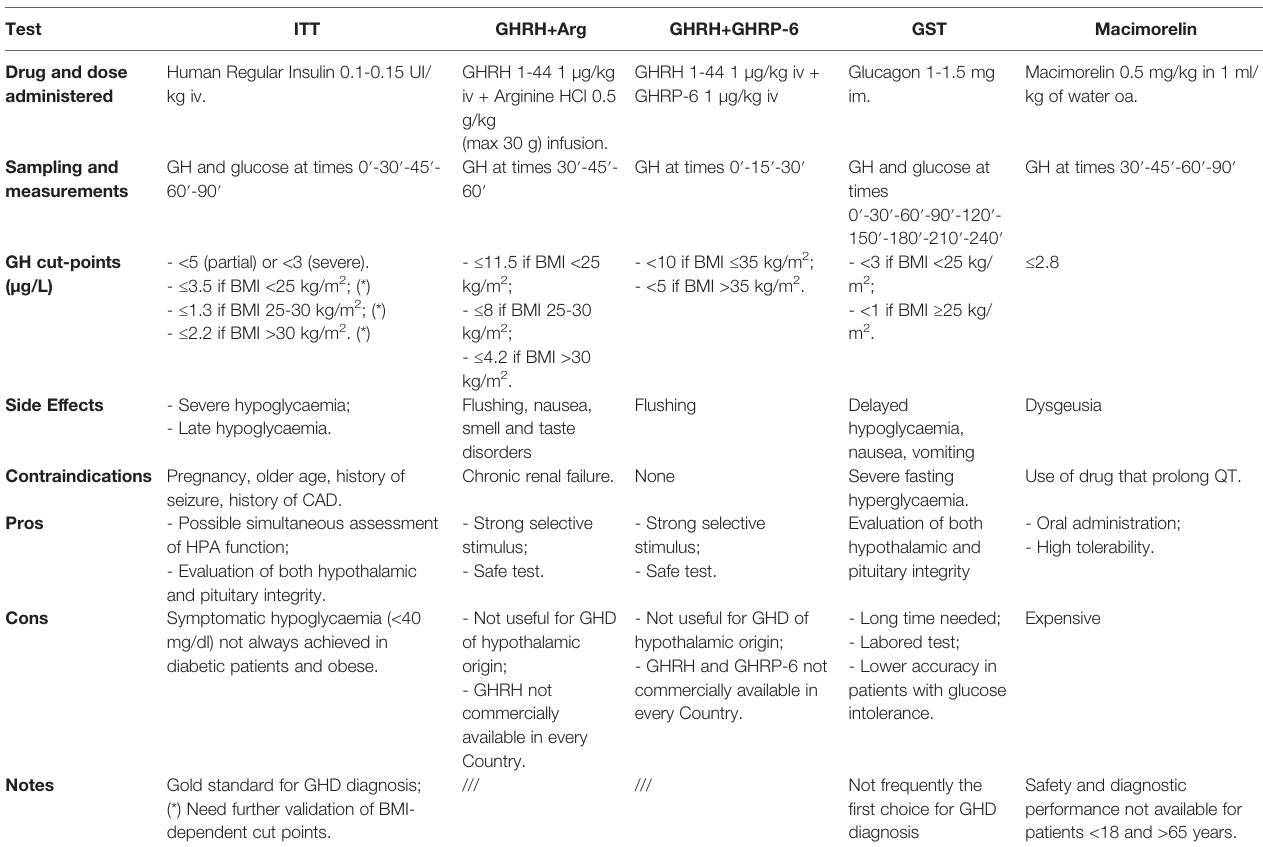
TABLE 1 | Main characteristics of GH stimulation tests.